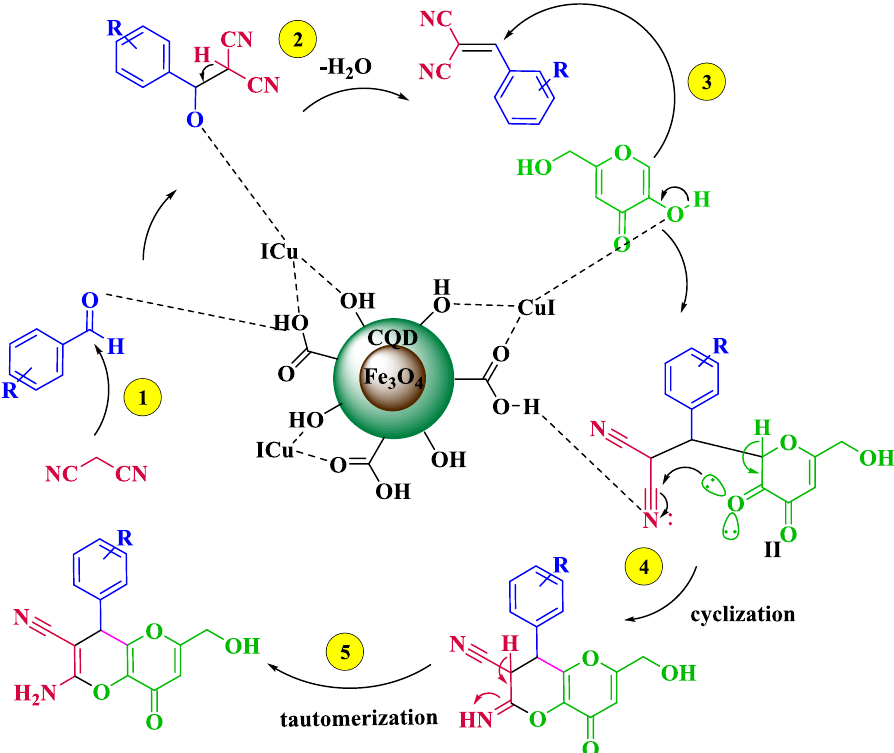
Figure 11. Proposed mechanism for the synthesis kojic acid based dihydropyrano-pyran using Fe 3 O 4 @CQD@ CuI.